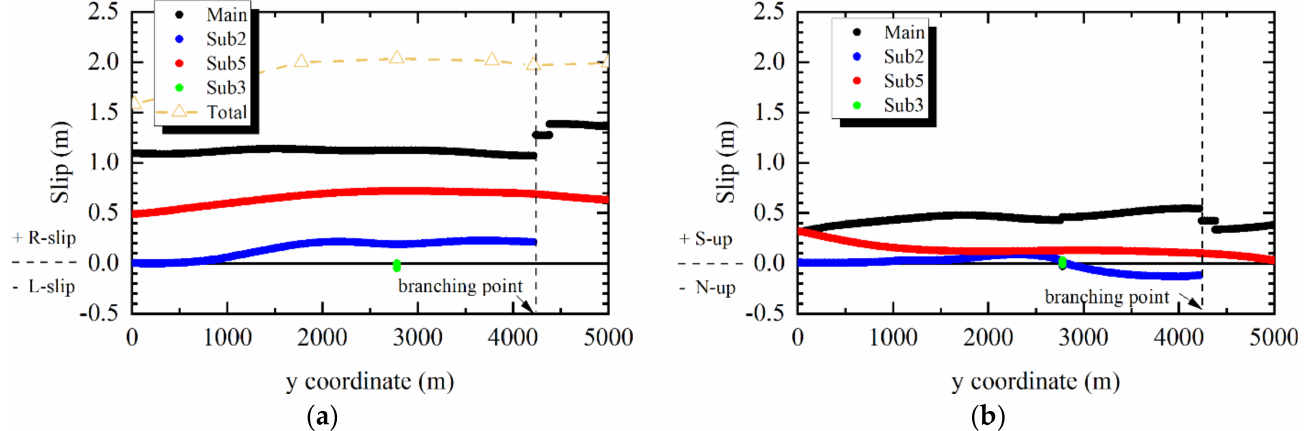
Figure 11. Profiles of the surface slip on the main and sub-faults (case1, ∆ = 2.6 m). ( a ) Strike-slip com- ponent. The yellow dashed line plot “Total” shows the estimated total slip. ( b ) Vertical